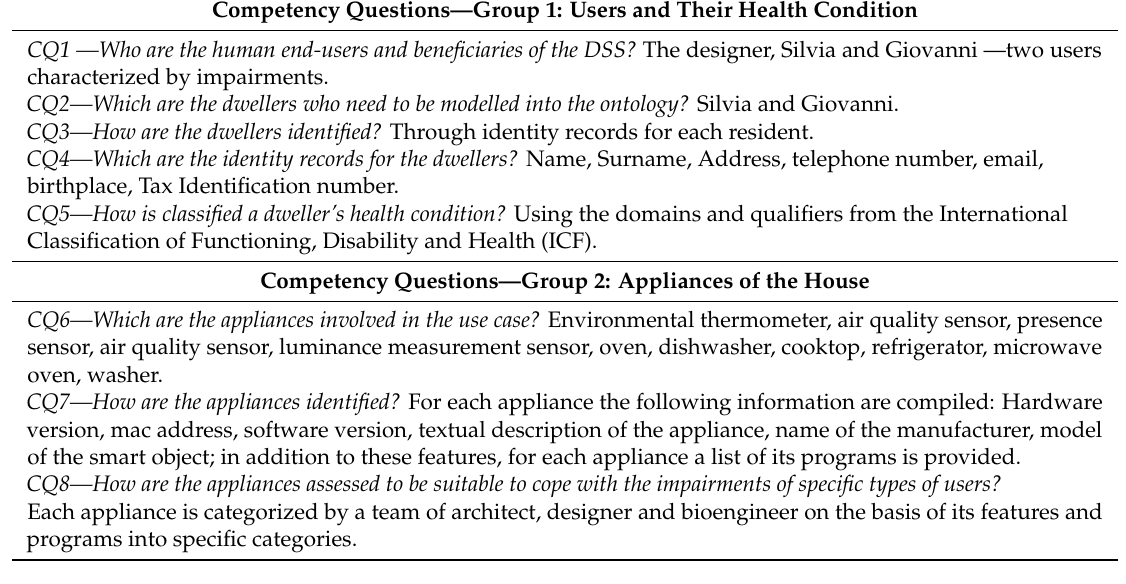
Table 1. The list of Competency Questions